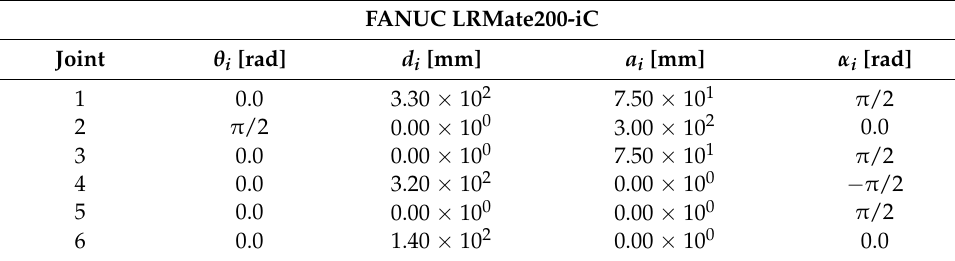
Table 7. D-H parameters for the FANUC LR Mate 200iC.